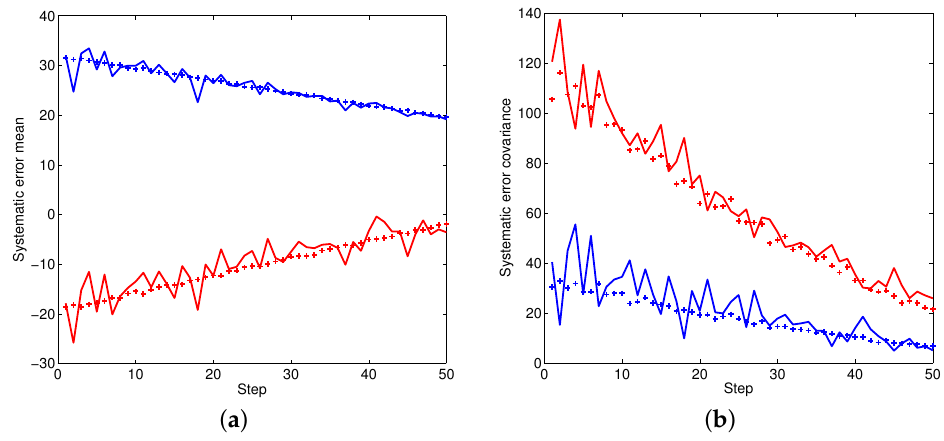
Figure 3. The statistic properties of the systematic error for object two. ( a ) Mean of systematic error; ( b ) Covariance of systematic error.